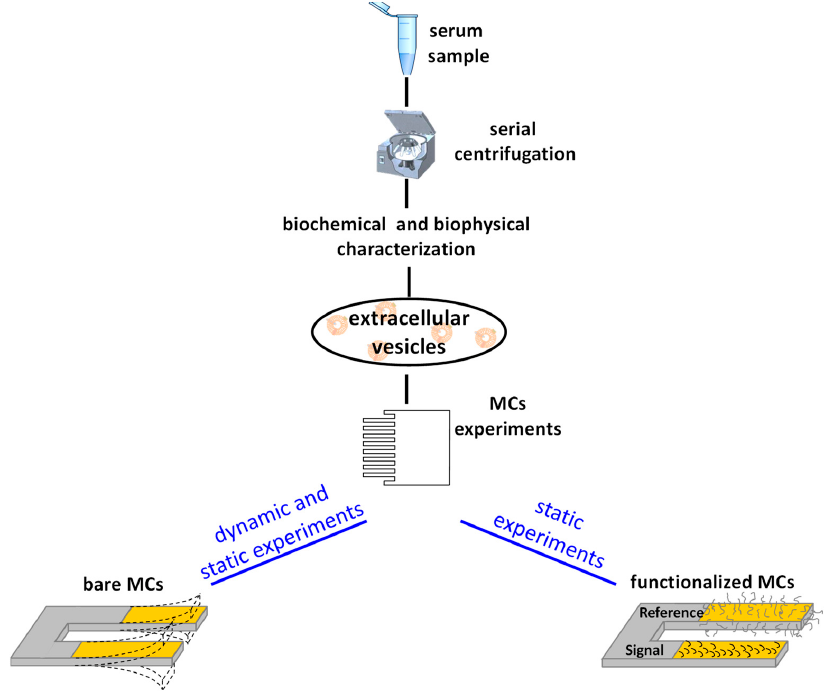
Figure 1. Protocol of the experimental steps. Scheme of the experimental process.